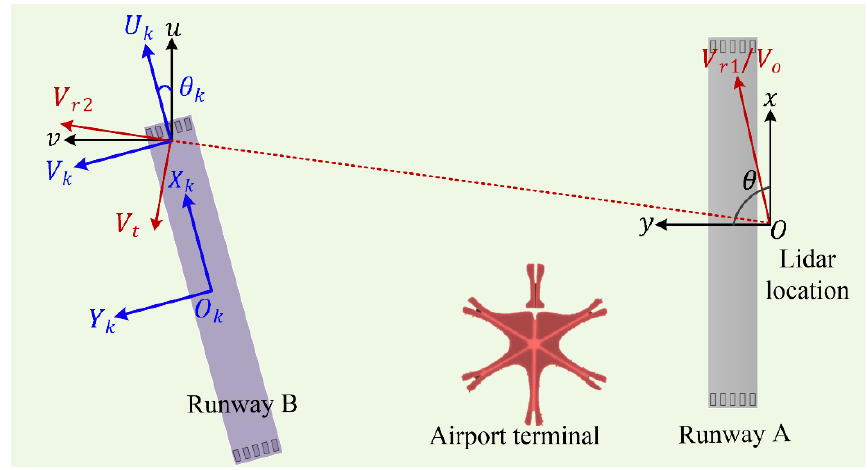
Figure 1. Diagrams of coordinates and velocities.